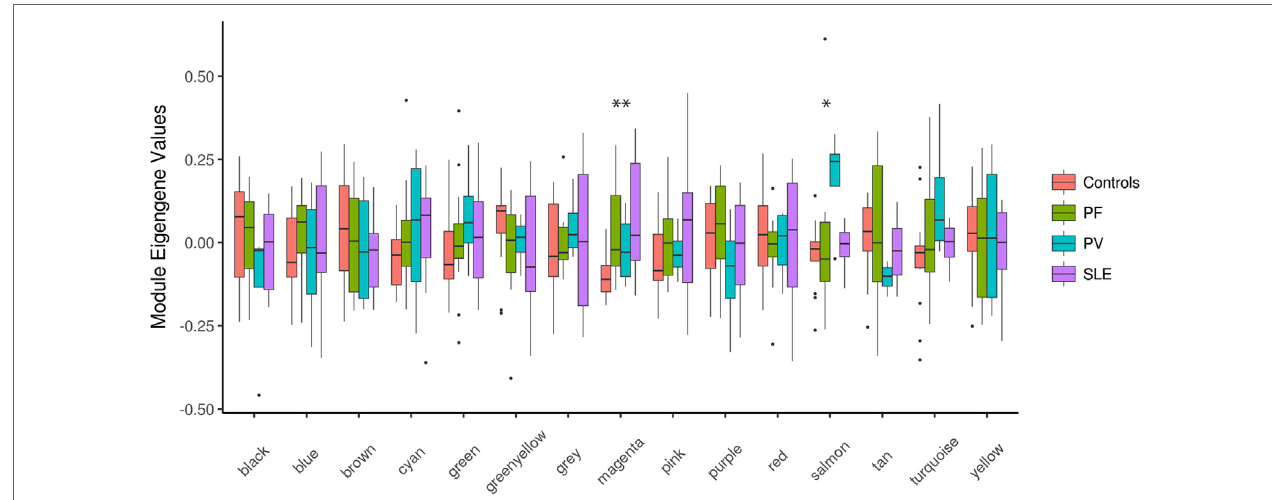
FigUre 2 | Boxplots of eigengene values across modules. Boxplots depicting different identified modules on the X -axis and the corresponding module eigengene values for each group of samples on the Y -axis. The significance among the groups was calculated using Kruskal–Wallis test. * P < 0.05; ** P < 0.01. PF, pemphigus foliaceus; PV, pemphigus vulgaris; SLE, systemic lupus